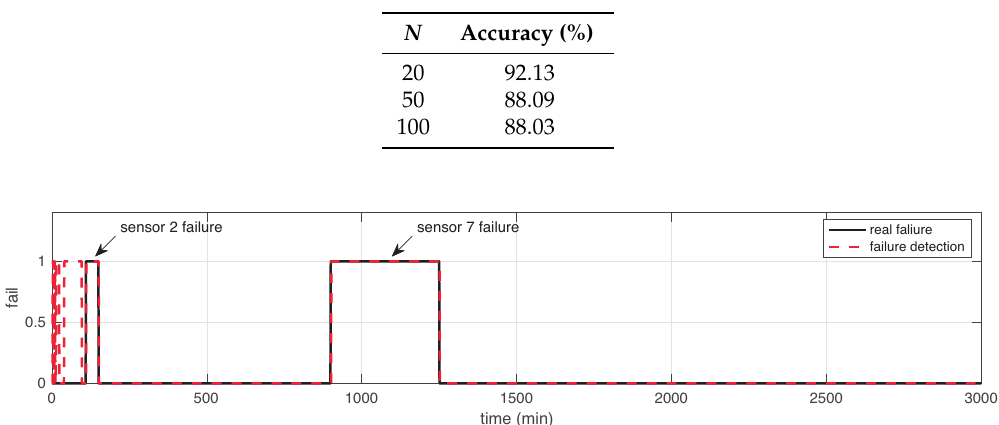
Table 1. Accuracy in failure detection in different simulated WSN.